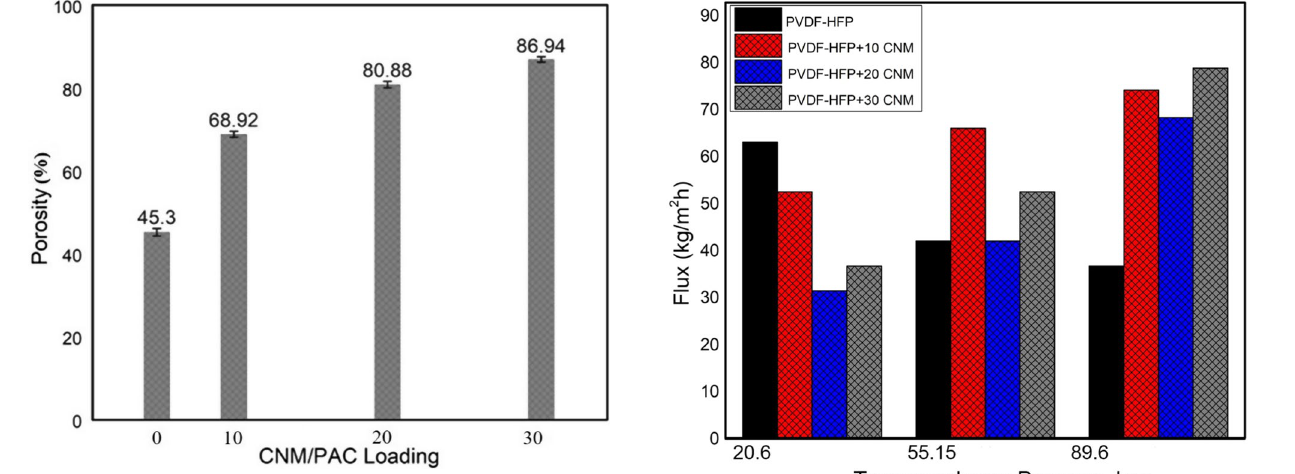
Fig. 7 Flux of the membranes by water pressure difference across the